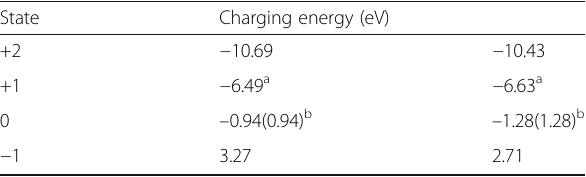
Table 1 Charging energy E N – 1 – E N of different charge states